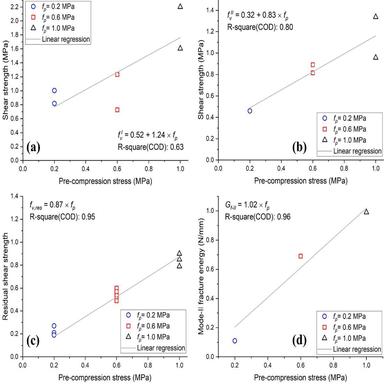
Shear strength evaluated at the first peak (a), shear strength evaluated at the second peak (b), residual shear strength (c) and mode-II fracture energy (d) as a function of pre-compression stress.